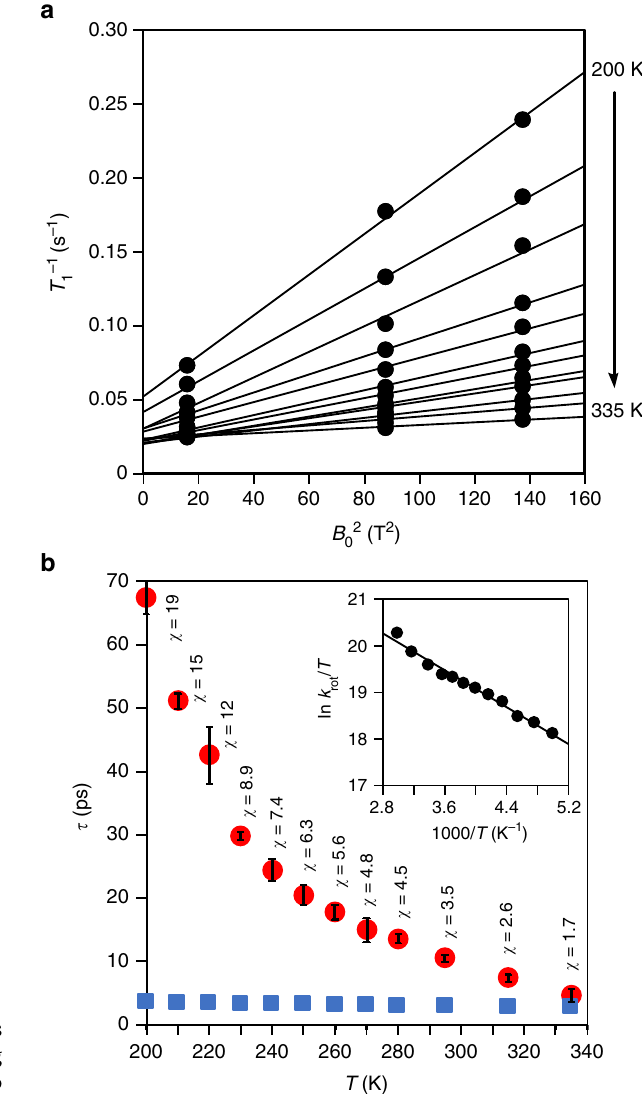
Fig. 3 Rotational dynamics revealed from spin-lattice relaxation time ( T 1 ) measurements. a Field-dependent T 1 values for the temperature range of 200 – 335 K under three different magnetic fi elds (4.00, 9.39, and 11.7 T). A linear correlation was visualized by plotting the reciprocal T 1 against the square of the magnetic fi eld B 0 2 , and the rotational correlational time ( τ ) was obtained from the slope. b Temperature-dependent τ values. Experimental τ values are shown in red circles, and theoretical natural-limit values, τ FR , are shown in blue squares. The bars show the standard errors of the estimate. The dynamics measures of χ ( = τ / τ FR ) are shown, and the smallest value, 1.7, revealed the presence of inertial rotational motions. The inset shows the Eyring plot adopting k rot ( = 1/ τ ) to disclose the energetics for the